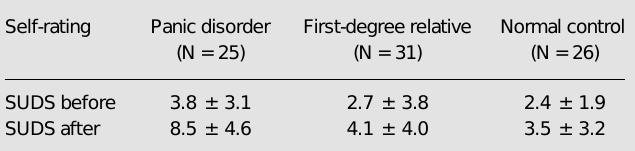
Table 2 - Subjective anxiety levels rated by the subjects just before and after hyperventilation (mean ± SD). SUDS, Subjective Units of Disturbance Scale. ANOVA, F = 2.311, d.f. = 2, P = 0.106 (Fisher’s protected least significant difference: panic disorder vs relatives, P = 0.058; panic disorder vs control, P = 0.070; relatives vs control, P =